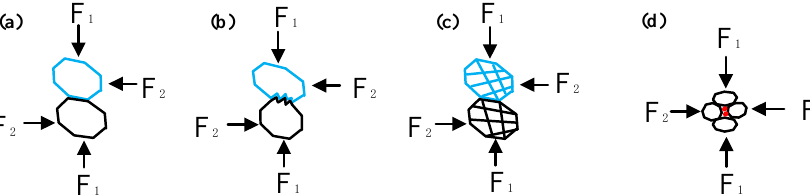
Figure 14. Schematic diagram of briquettes’ failure mode under loading. ( a ) The structural surface friction between particles, ( b ) structural wedge friction, ( c ) fragmentation along the fracture surface and ( d ) compaction of loose particles.